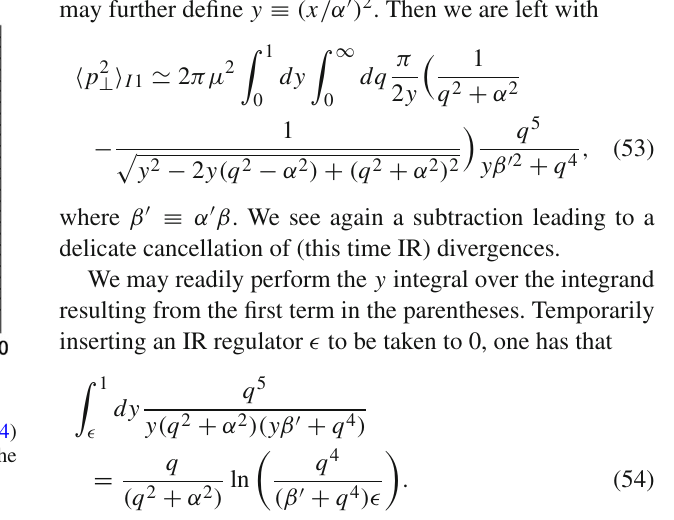
Fig. 13 Comparison between the full integrand Eq. (48) (thick, black) and the approximate integrand Eq. (50) (thin, green) for E = 1000 GeV, L = 5 fm and μ = 0 . 5 GeV